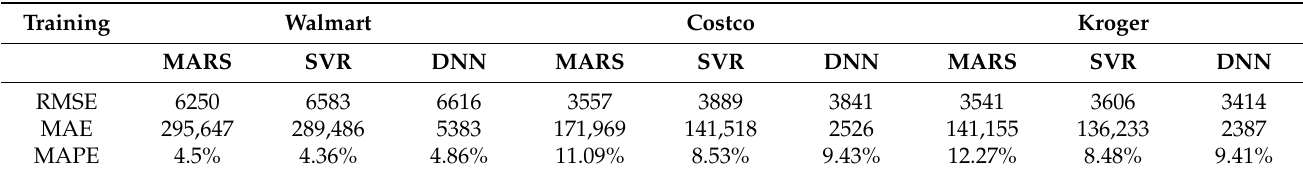
Table 4. Forecasting errors for the training set (2005/Q1~2019/Q4).